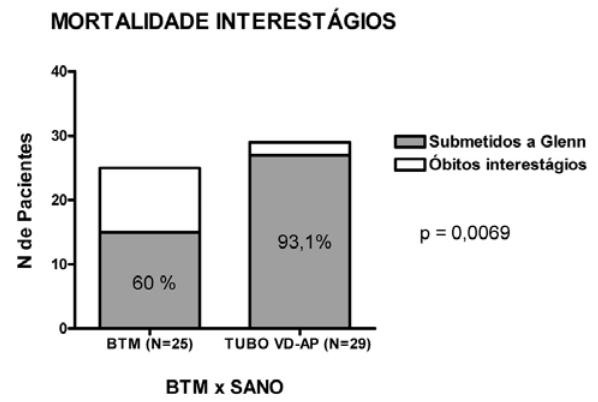
Fig 3 - Mortalidade interestágios - BTM= Blalock Taussig modificado